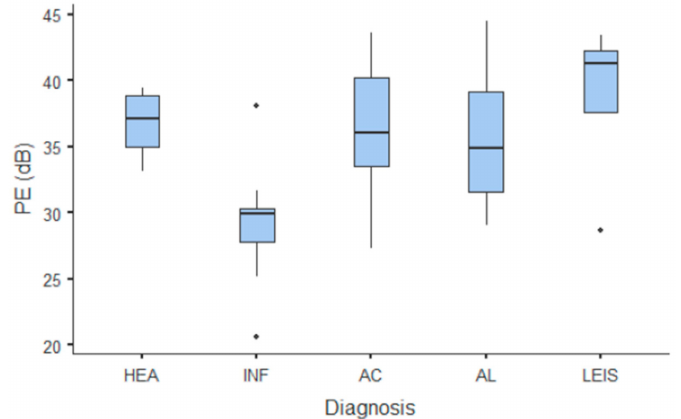
Figure 7. Box and whisker plot of the peak enhancement (PE) for healthy (HEA), inflammatory (INF), adenocarcinoma (AC), lymphoma (AL), and leiomyosarcoma (LEIS).